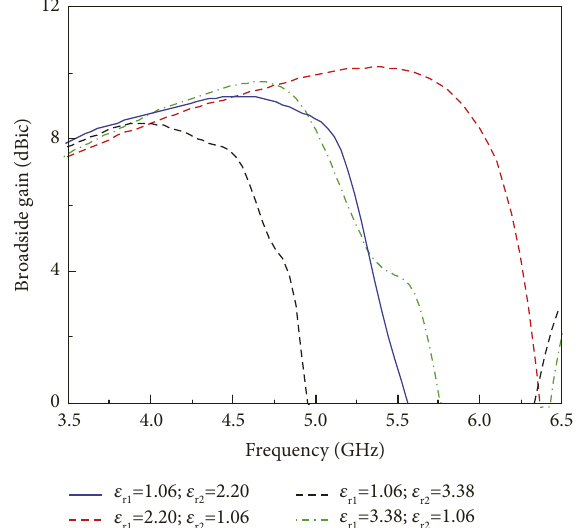
Figure 8: Effects of different dielectric constants for the lower and upper substrates on the axial ratio of the antenna.